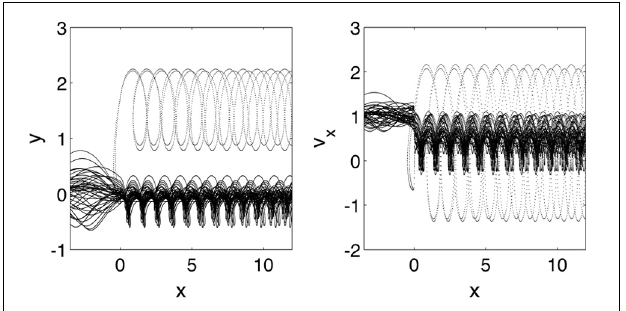
FIGURE 2 | Left: Trajectories of 40 randomly chosen ions in the x − y plane. Right: dependence of v x on x for the same ions. For the shock with